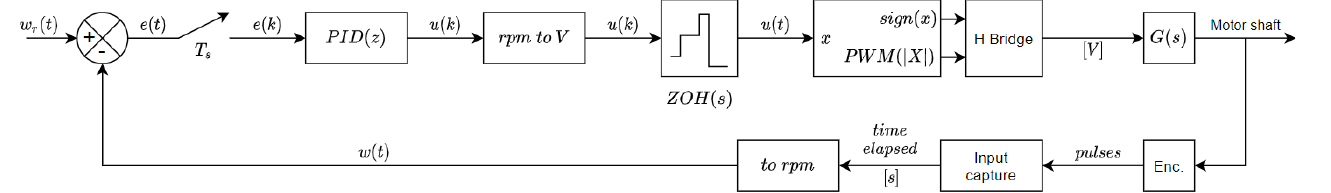
Figure 5. Representation of all steps and modules required to practically implement the PID controller of one motor of the APR-02 mobile robot. of one motor of the APR-02 mobile